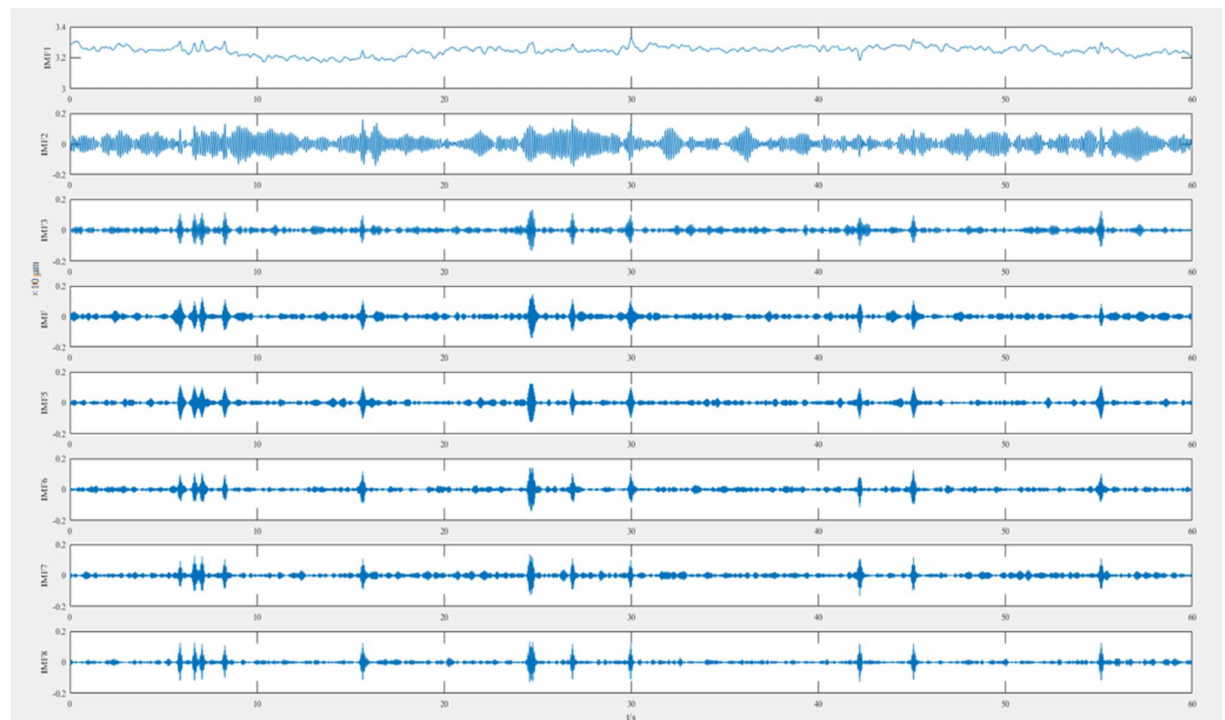
Figure 3. VMD decomposition diagram of the vibration signal in the different loading